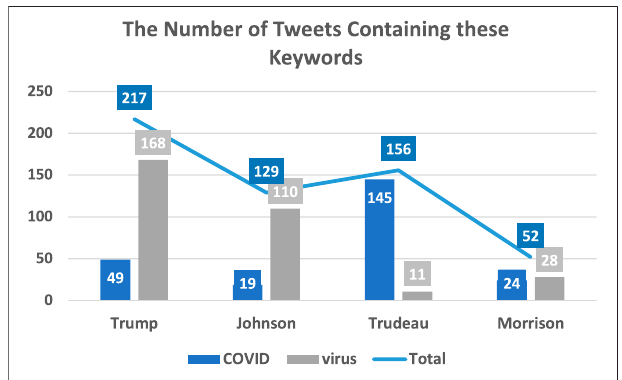
FIGURE 2 | The Number of Tweets Containing “ Covid ” and/or “ virus ”